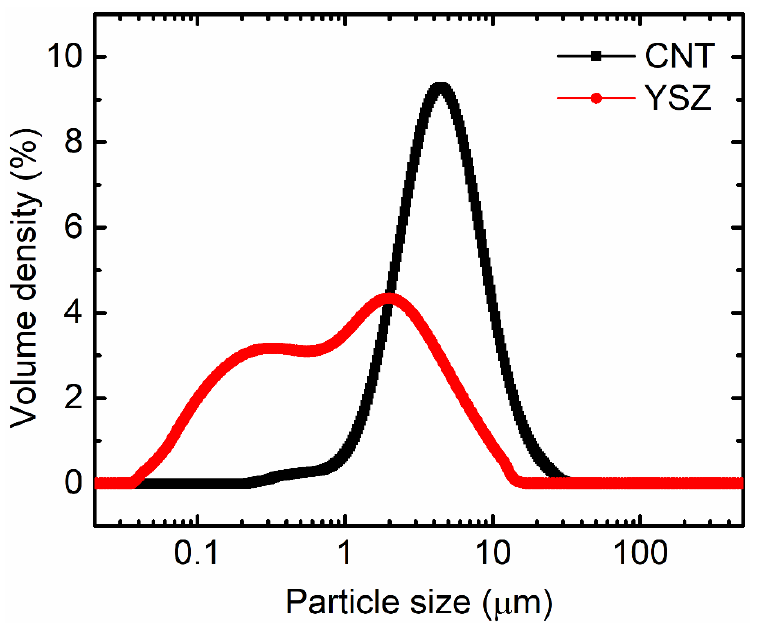
Figure 2. PSA analysis of as-received CNT and YSZ raw materials. Average particle size of CNT is 4.4 μm , whereas that of YSZ is 1.0 μm.